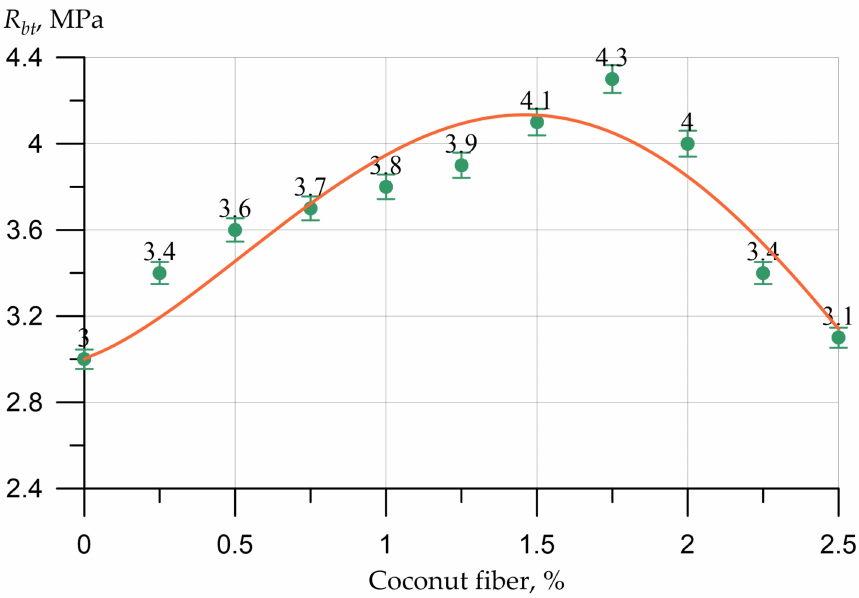
Figure 10. Dependence of the axial tensile strength ( R bt ) of prism concrete samples with dimensions of 100 × 100 × 400 (mm) on the percentage of dispersed reinforcement with coconut